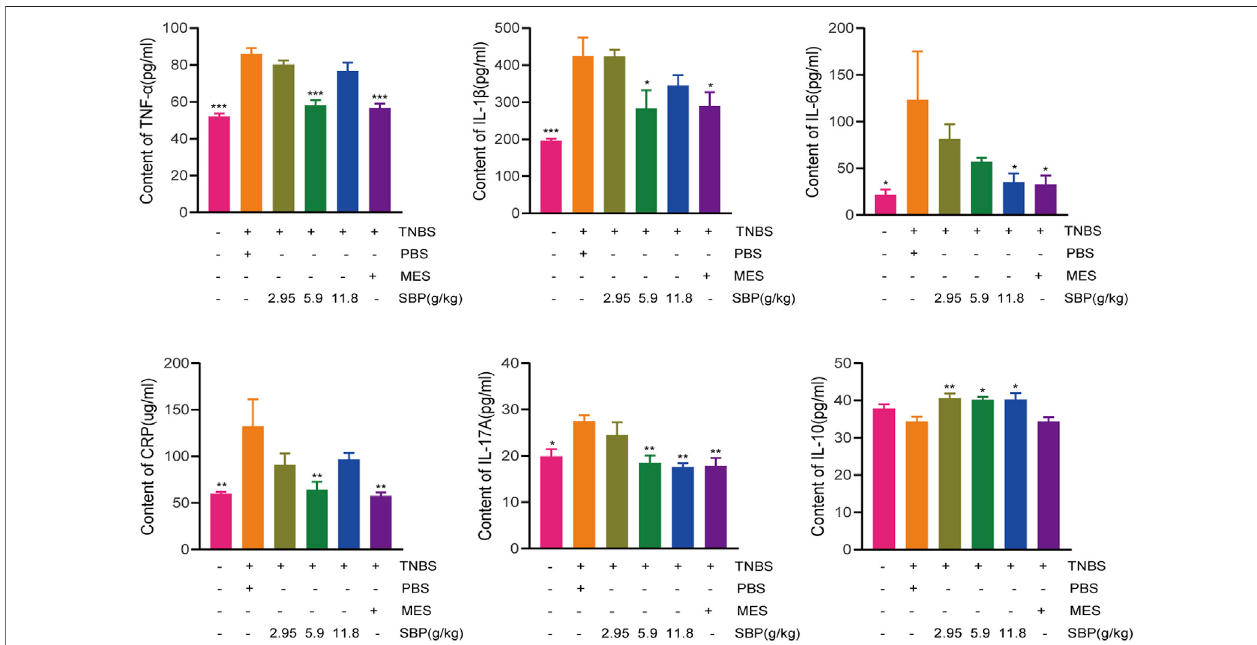
FIGURE 3 | Change of cytokine after SBP treatment . (A) TNF- α (B) IL-1 β (C) IL-6 (D) CRP (E) IL-17A and (F) IL-10 in serum. vs. TNBS + PBS group, n = 5 rats/ group. Data shown as means ± SEM. * p < 0.05, ** p < 0.01, *** p <